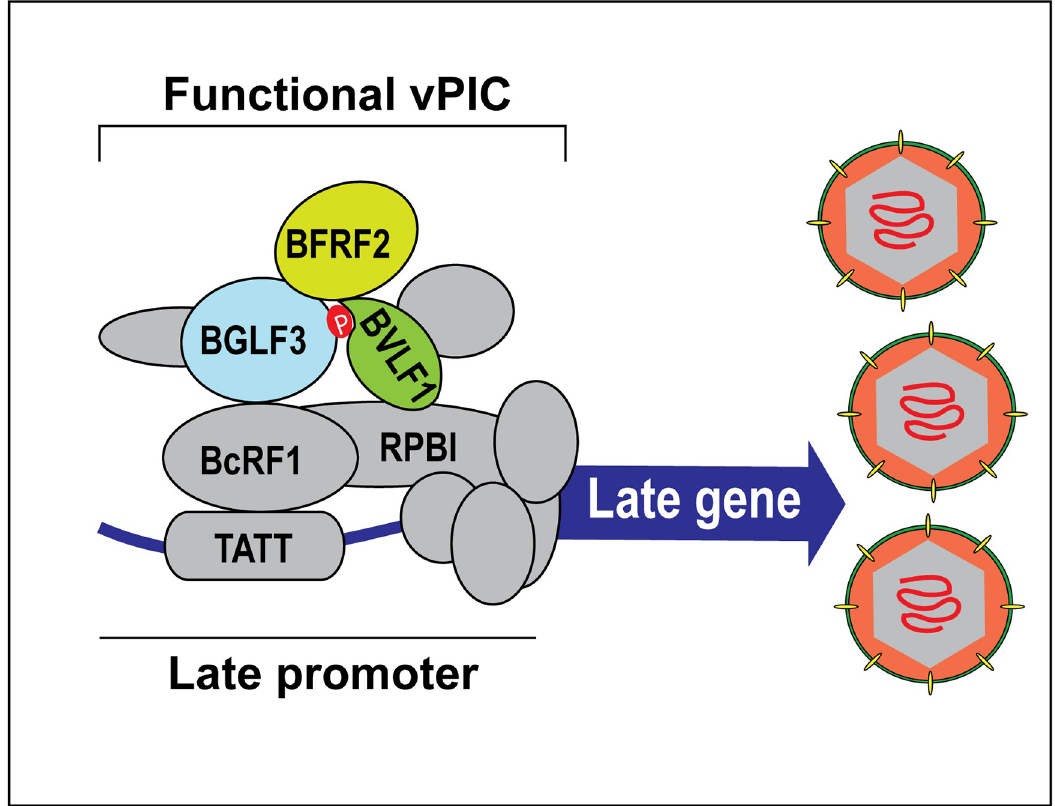
Fig 9. Model depicting the role of phosphorylation of BGLF3 at T42 in assembly of vPIC. BGLF3 is a core component of EBV transcription pre-initiation complex (vPIC). BGLF3 is phosphorylated at T42, a site conserved in gammaherpesviruses. Phosphorylation of BGLF3 at T42 is essential for recruitment of BVLF1 to the preinitiation complex. Lack of phosphorylation at T42 abolishes expression of EBV structural proteins and production of virus